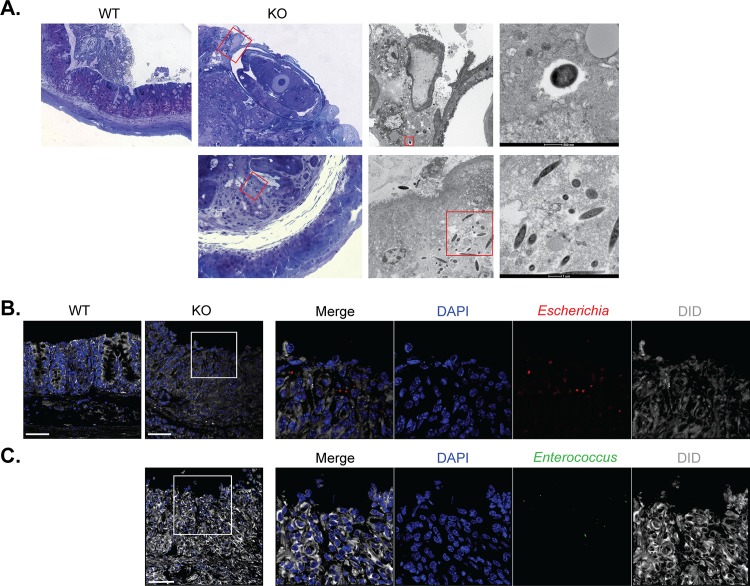
IL-10 signalling during T. muris infection maintains intestinal barrier limiting Enterococcus and Escherichia bacterial translocation through the caecal epithelium.(A) Representative transmission electron micrographs of T. muris-infected WT and IL-10 signalling-deficient mice (Il-10, Il10ra-/- and Il10rb-/-) caecal tissues, showing translocation of cocci and rod-like bacteria. (B) Representative immunofluorescence of Escherichia spp. in the caecum of T. muris-infected WT and IL-10 signalling-deficient mice (Il-10, Il10ra-/- and Il10rb-/-). DiD stains membranes and DAPI stains cell nuclei. Scale bar, 50 μm. (C) Representative immunofluorescence of Enterococcus spp. in the caecum of T. muris-infected WT and IL-10 signalling-deficient mice (Il-10, Il10ra-/- and Il10rb-/-). DiD stains membranes and DAPI stains cell nuclei. Scale bar, 50 μm. Results are from two independent replicas (n = 3–4 each).